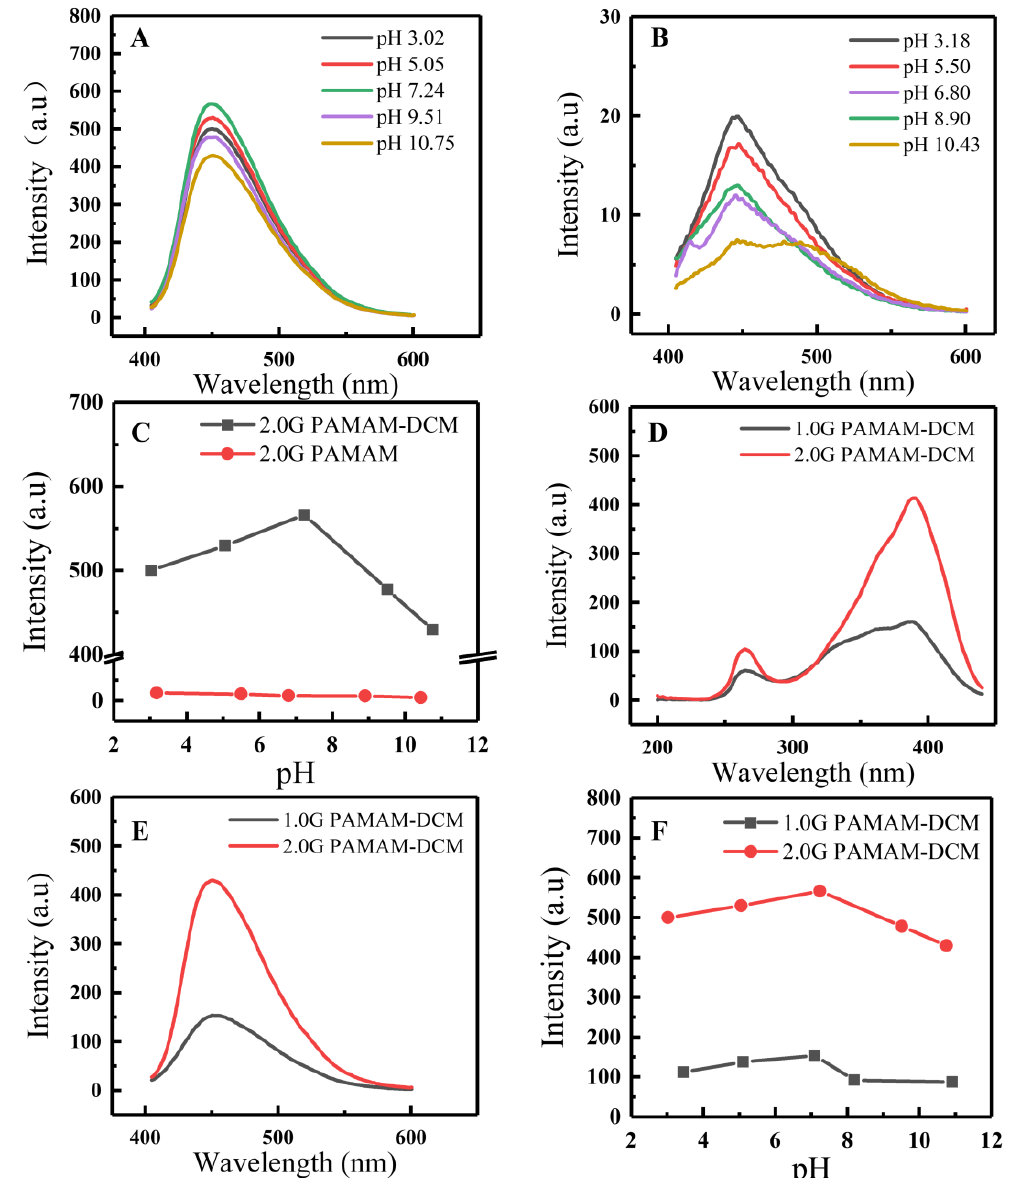
Figure 5. Fluorescence emission ( λ EX = 390 nm) spectra of ( A ) 2.0G PAMAM-DCM PDs, ( B ) 2.0G PAMAM, and ( C ) fluorescence intensity ( λ EM = 450 nm) at various pH; ( D ) fluorescence excitation and ( E ) emission ( λ EX = 390 nm) spectra of 1.0G PAMAM-DCM PDs and 2.0G PAMAM-DCM PDs, and ( F ) fluorescence intensity ( λ EM = 450 nm) at various pH.